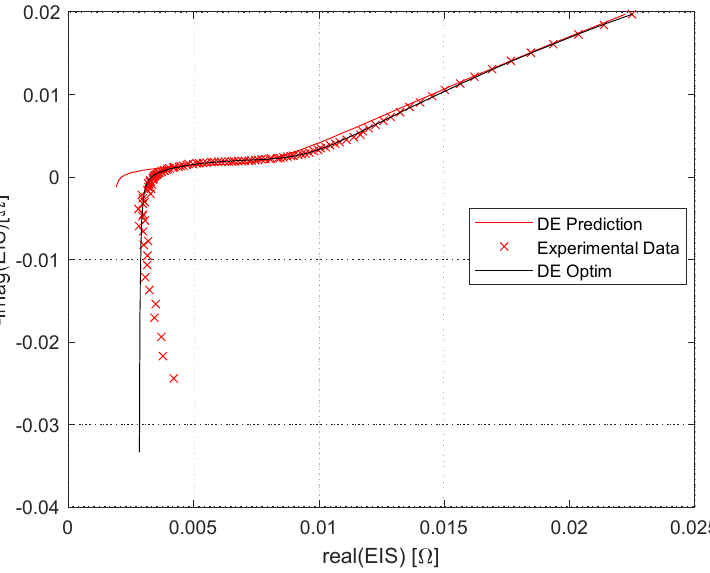
Figure 4. Comparison between one-step DE optimization-based identification result and two-step DE optimization-based identification results at 80% SoC.